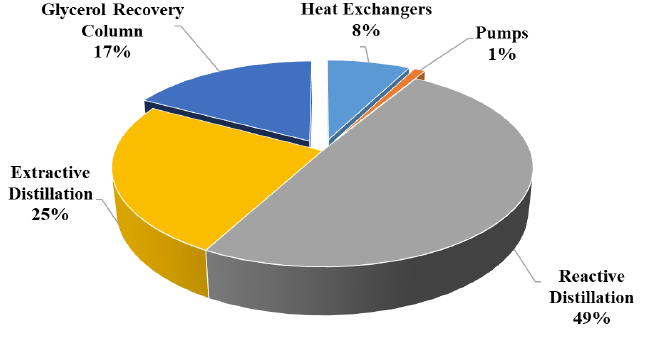
Figure 15. Purchased costs distribution of the main equipment for the glycerol etherification process based on reactive distillation.